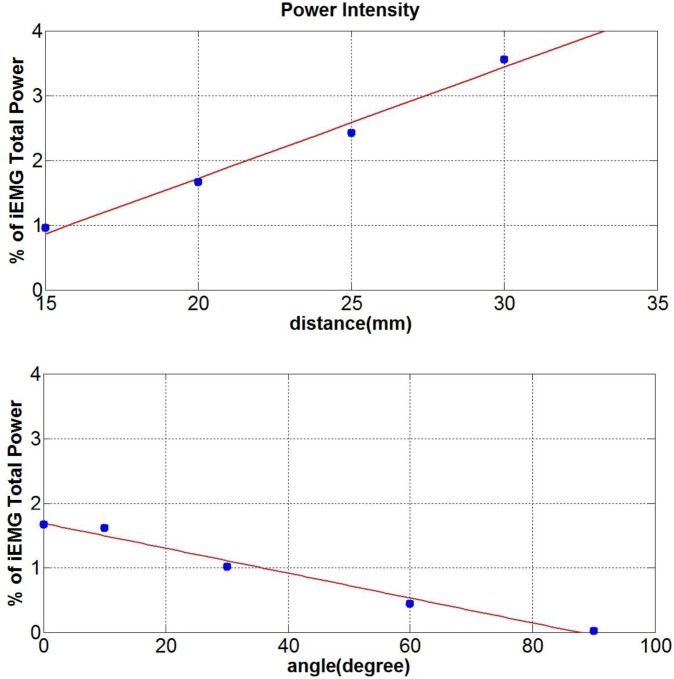
Total Power expressed as percentage of the source signal total power.(Top) Total power for different IED, showing a positive linear trend as the distance is increasing (Bottom) Total Power at different orientation, showing a decay as the electrodes alignment deviate from 0° to 90°.